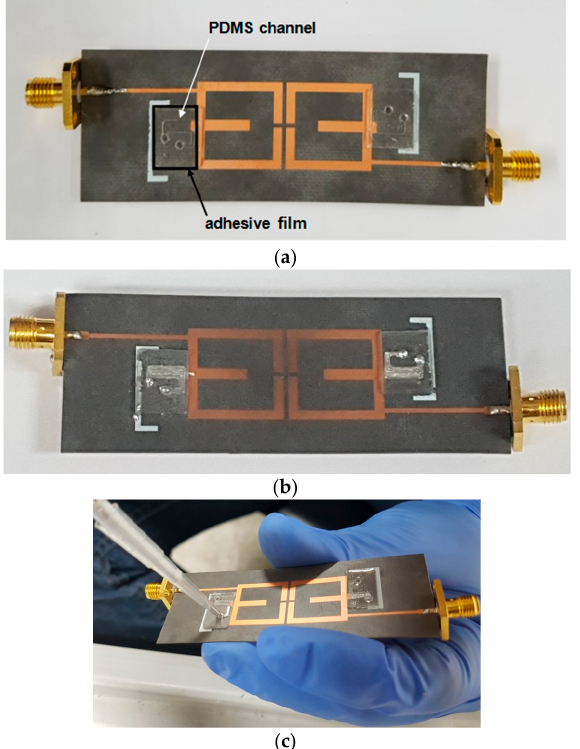
Figure 6. Pictures of the fabricated proposed filter: ( a ) without EGaIn; ( b ) with EGaIn; and ( c ) in the process of injecting EGaIn.